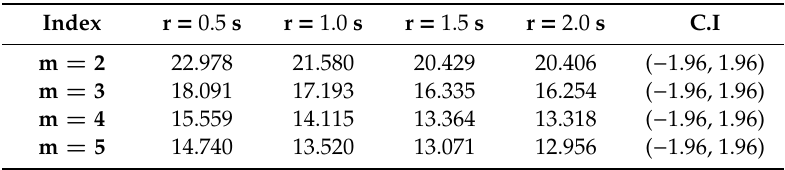
Table 3. Brock–Dechert–Scheinkman (BDS) statistic results of observed daily rainfall (09: Geoje): all values of BDS statistics results are out of Confidence Interval. The null hypothesis is rejected, and observation data is determined as nonlinear data. The results of the other stations are shown in the Supplementary Materials, Appendix B.